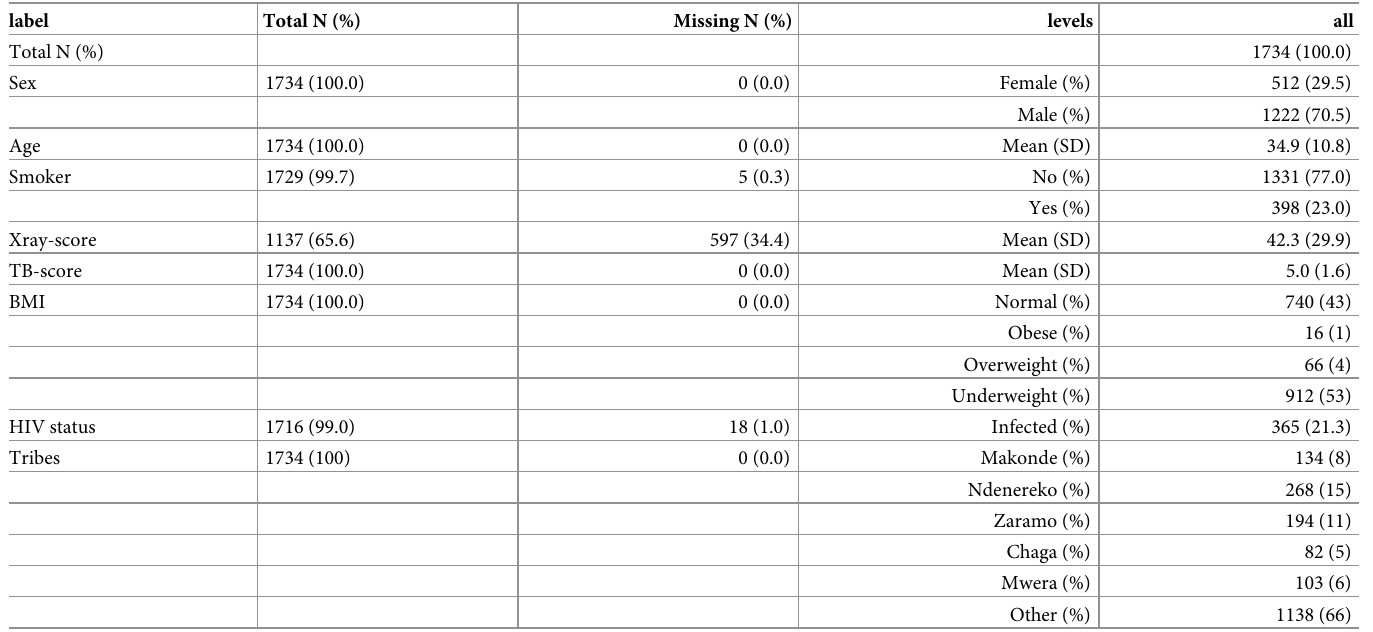
Table 1. Clinical and sociodemographic characteristics of patients recruited. The tribes named are those with at least 70 members among our patient population.